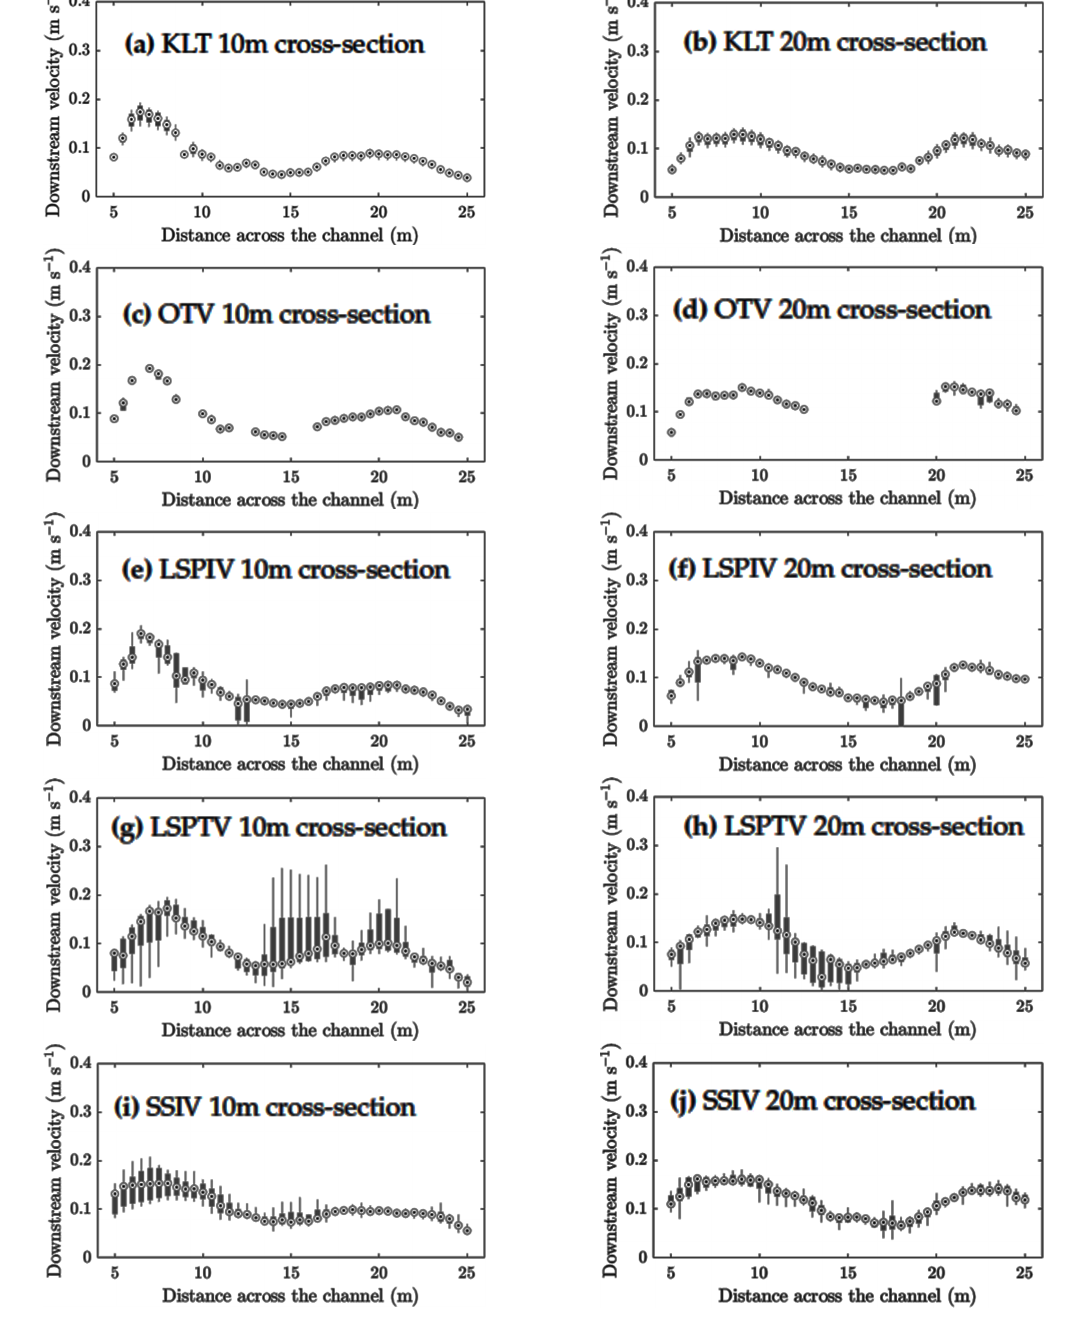
Figure 7. Sensitivity Analysis results for all algorithms at two cross-sections (Represented by red dashed lines in Figure 2). The distance across the channel relates to the y co-ordinates in Figures 2, 4 and 6. 5 m is the right bank, and 25 m is the left